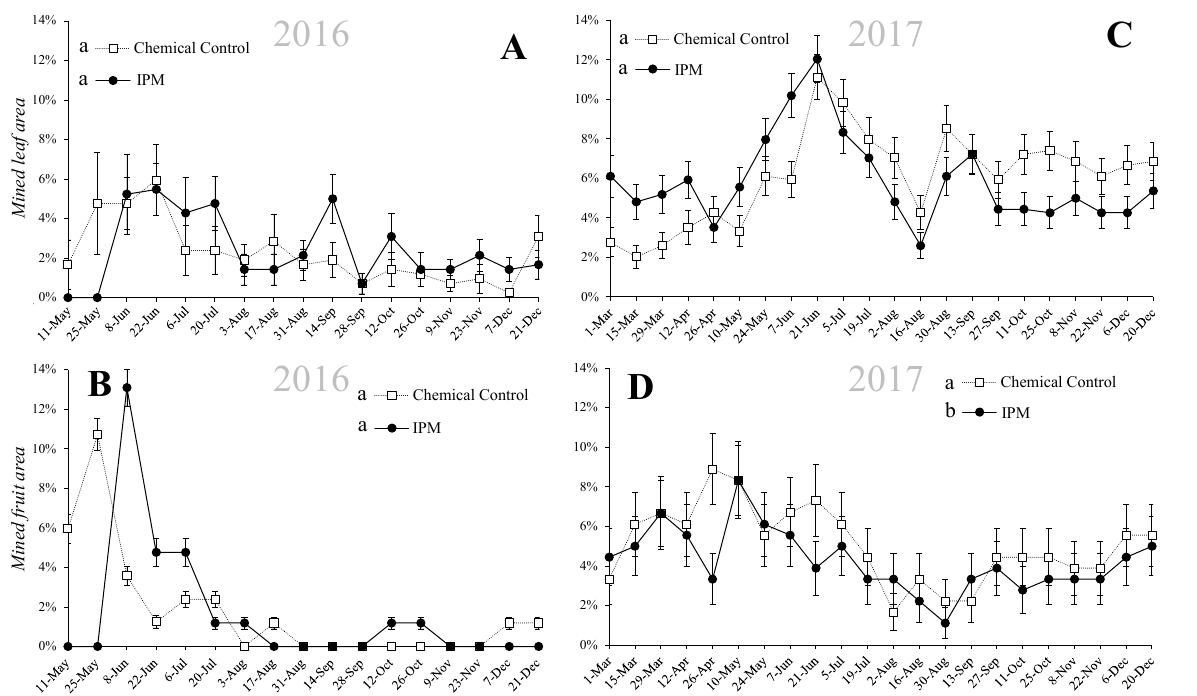
Figure 3. Percentage (mean ± SE) of leaf damage in 2016 ( A ) and 2017 ( C ) and percentage of fruit damage (mean ± SE) in 2016 ( B ) and 2017 ( D ) caused by C. chalcites larvae in each treatment. Legends with different letters were significantly different (GLMM, p < 0.05).